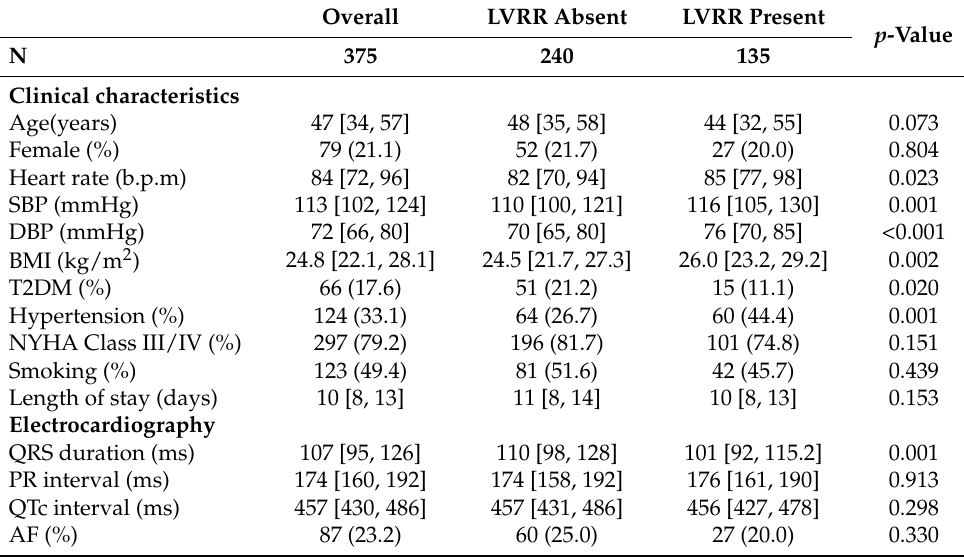
Table 1. Baseline characteristics for DCM patients with LVRR absent and LVRR